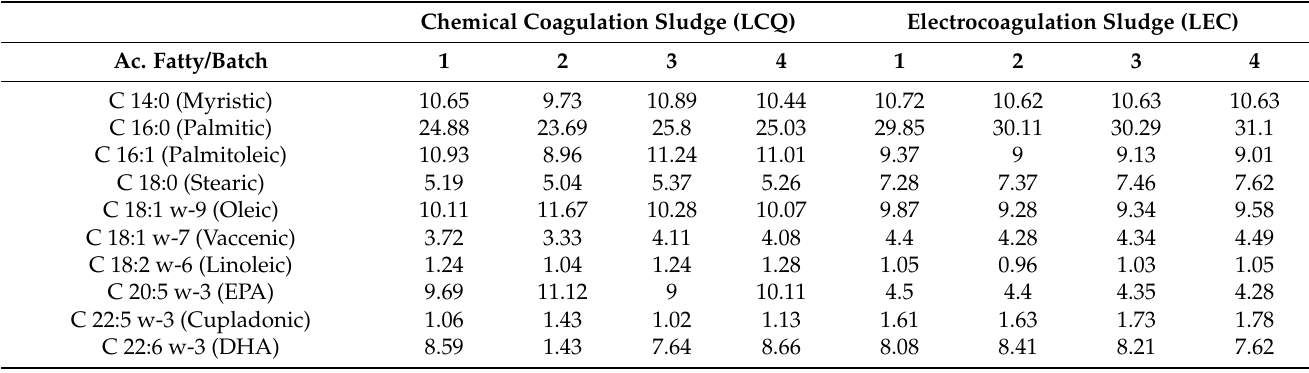
Table 3. Fatty acid profile of the fat extracted from the sludge from PW. The values are expressed in